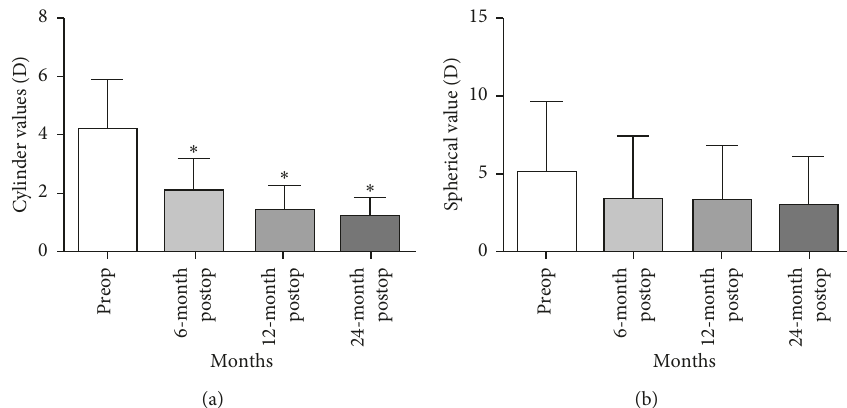
Figure 3: Preoperative and postoperative refractive outcomes. (a) Phototherapeutic keratectomy combined with PRK and CXL significantly reduced cylinder values ( P < 0 . 05) at 6, 12, and 24 months follow-up. (b) Phototherapeutic keratectomy combined with PRK and CXL did not significantly reduce spherical equivalent refractions at 6, 12, and 24 months follow-up. ∗ Preoperatively vs postoperatively 6, 12, and 24 months P < 0 . 05.